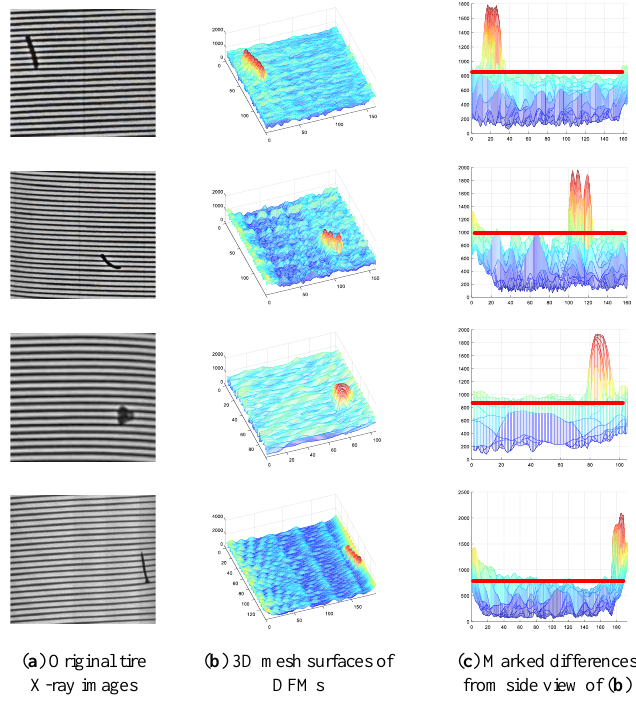
Figure 7. Illustration of DFMs from different tire X-ray